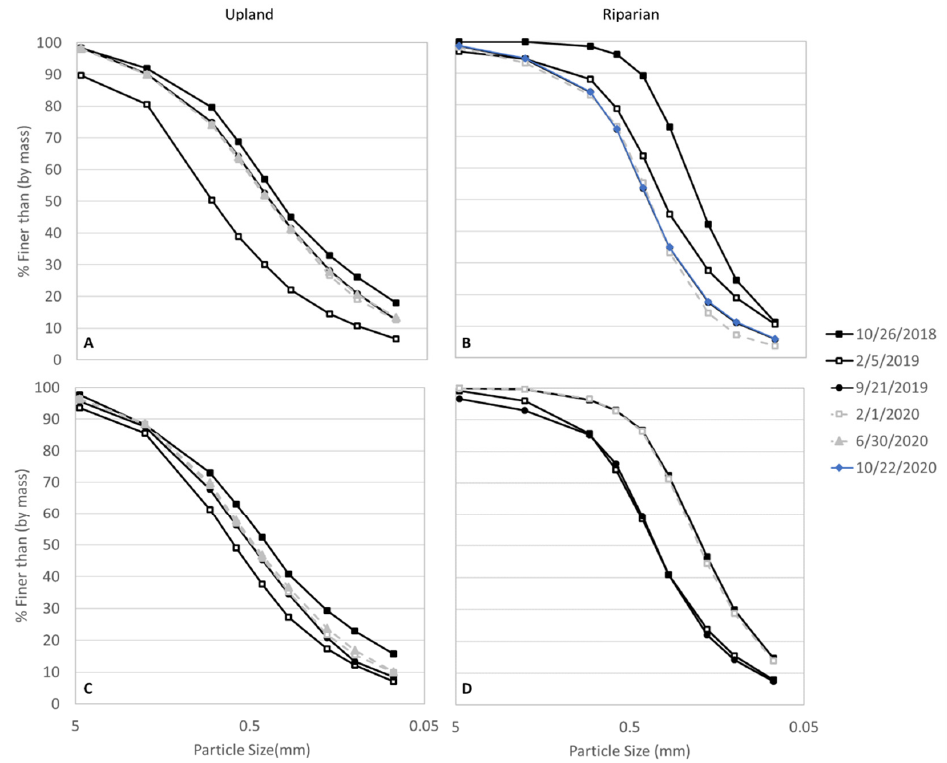
Figure 3. Particle-size distribution for ( A ) upland and ( B ) riparian upper soil depths and ( C ) upland and ( D ) riparian lower soil depths.